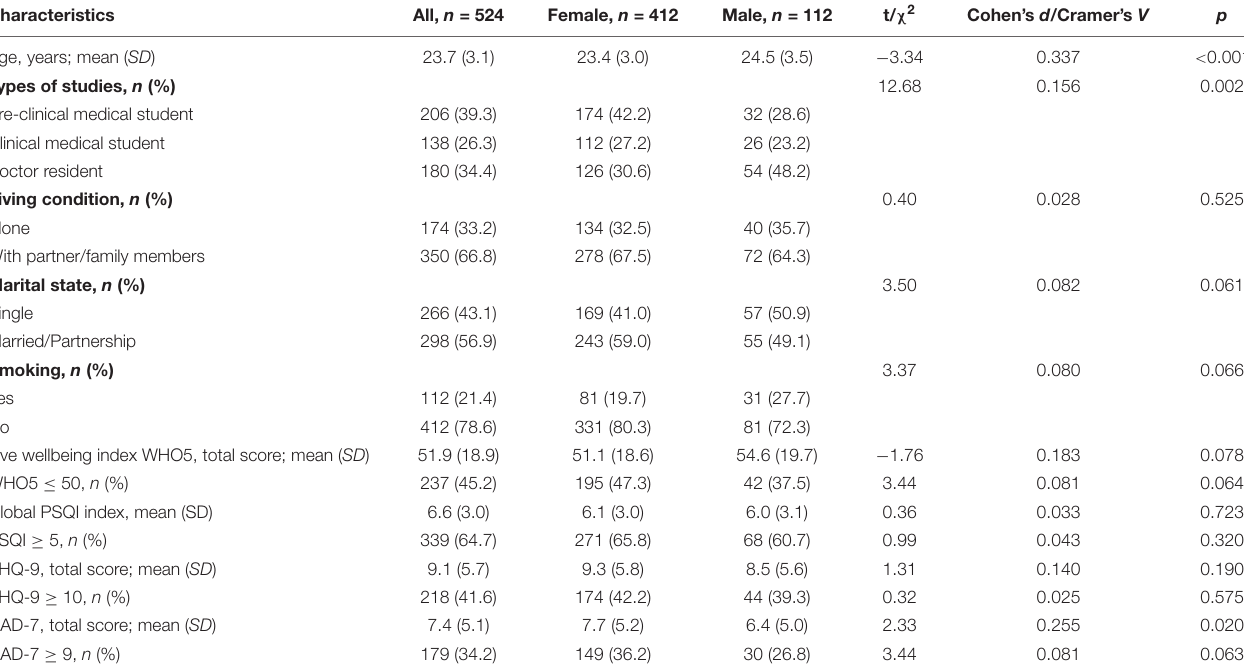
TABLE 1 | Socio-demographic characteristics and subjective psychological assessments in study participants.